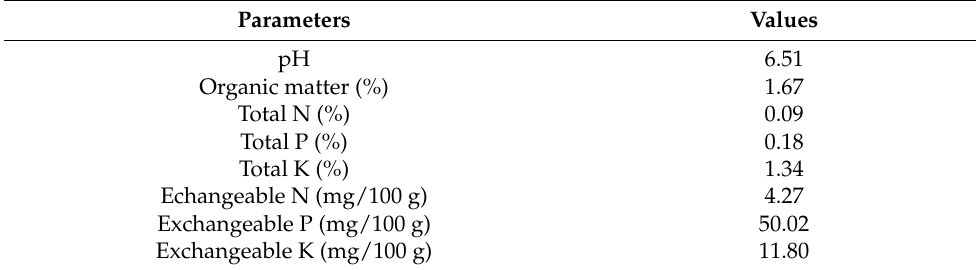
Table 1. The initial physical and chemical properties of the experimental